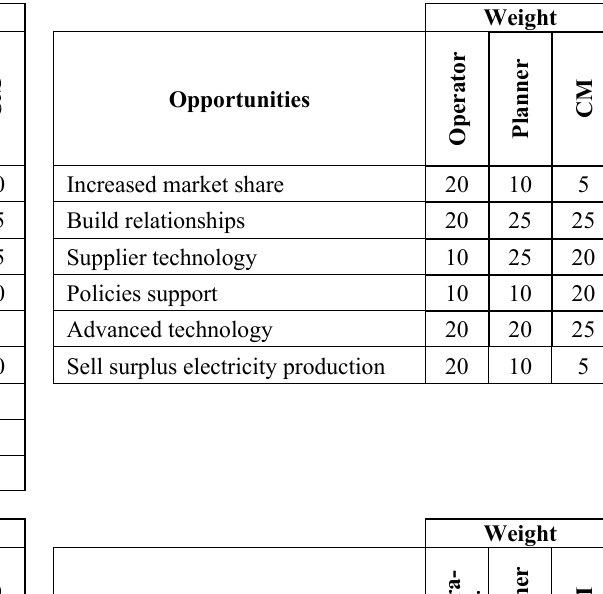
Sub criteria weightings.